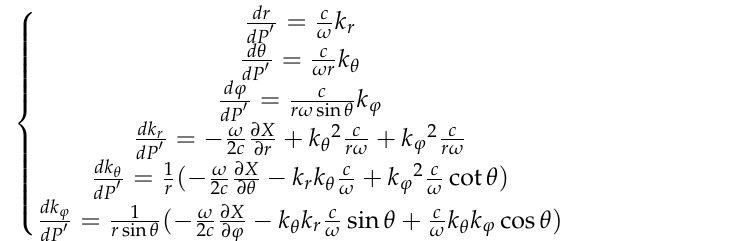
Table 6. The meaning of related parameters in the above Formula (11). Number Parameter Representation 1 P ’ The group path 2 c The speed of light 3 ω = 2 π f The angular frequency of the radio wave 4 f The frequency of the radio wave 5 ω pe The angular frequency of the plasma Refractive